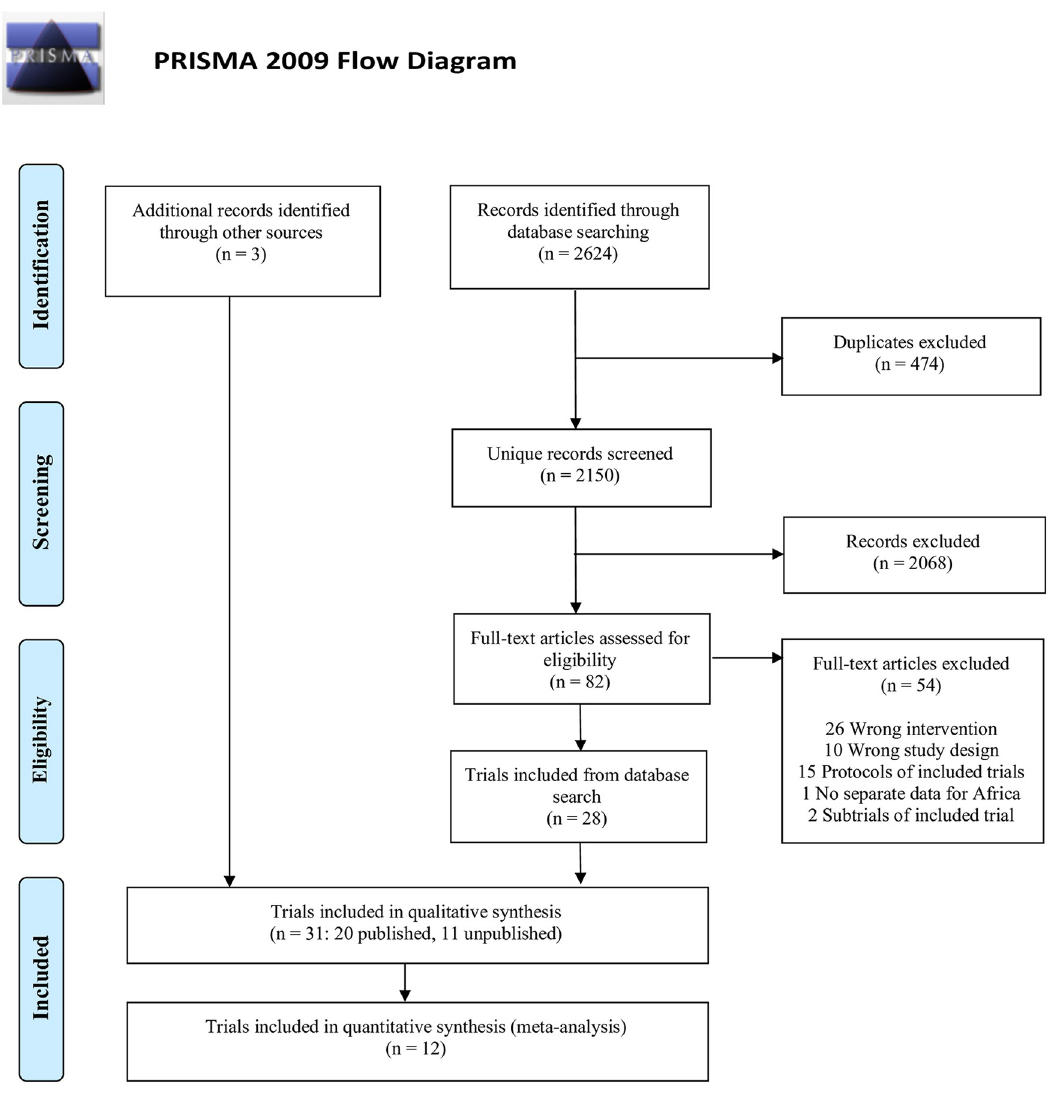
Fig 1. Flow diagram. From : Moher D, Liberati A, Tetzlaff J, Altman DG, The PRISMA Group (2009). P referred R eporting I tems for Systematic Reviews and M eta- A nalyses: The PRISMA Statement. PLoS Med 6(7): e1000097. doi:10.1371/journal.pmed1000097. For more information, visit